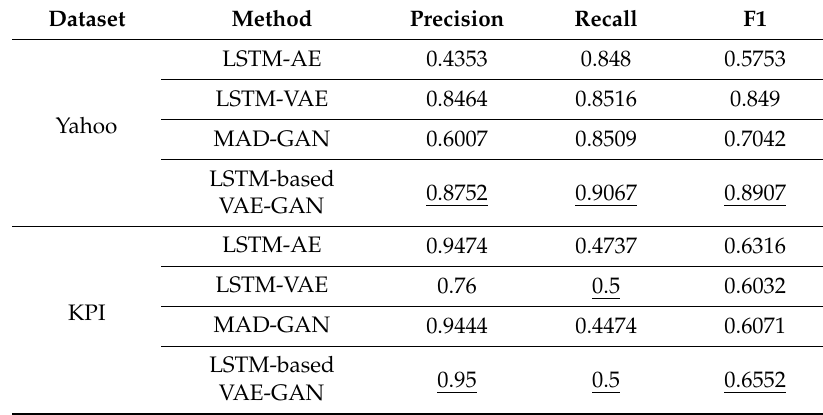
Table 1. Precision, Recall and F1 score of representative time series anomaly detection methods based on sample reconstruction and our method LSTM-based